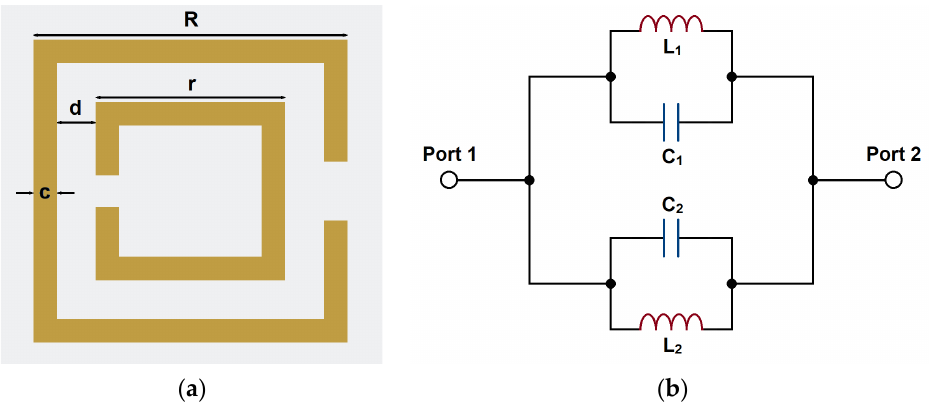
Figure 4. The structure of CSRR: ( a ) topology and ( b ) equivalent circuit